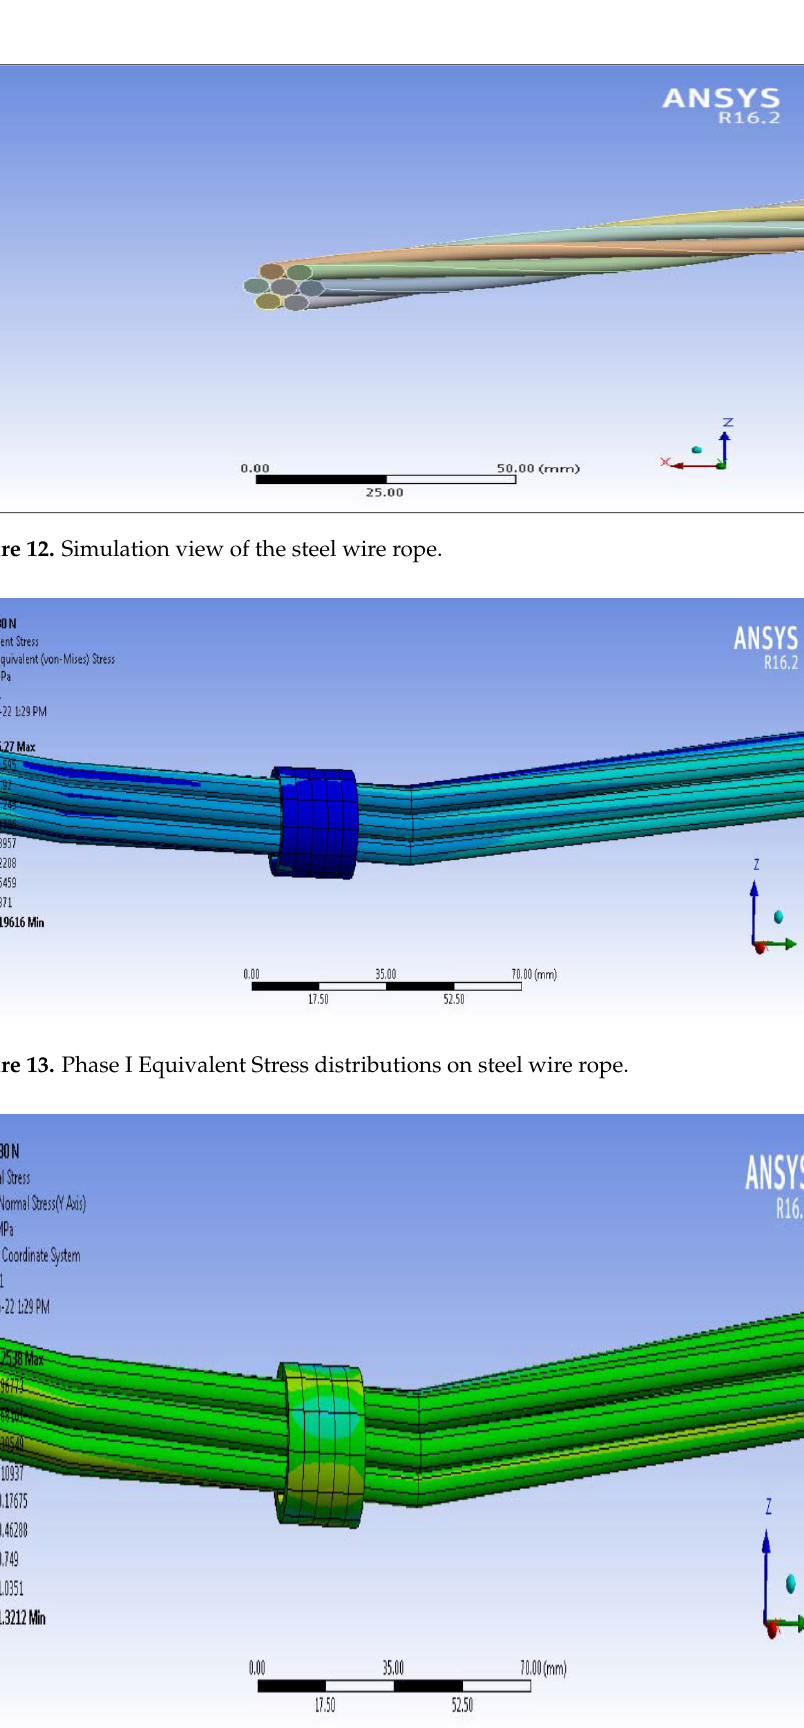
Figure 15. Phase II Equivalent Stress distributions on steel wire rope.